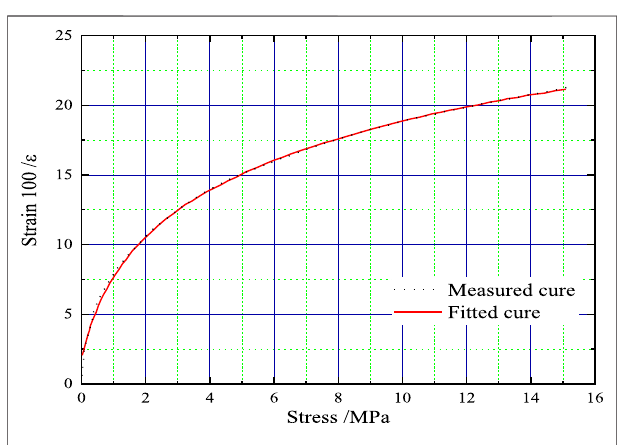
FIGURE 7 | Measured and fi tted stress – strain curves ( n (cid:1) 0.5).